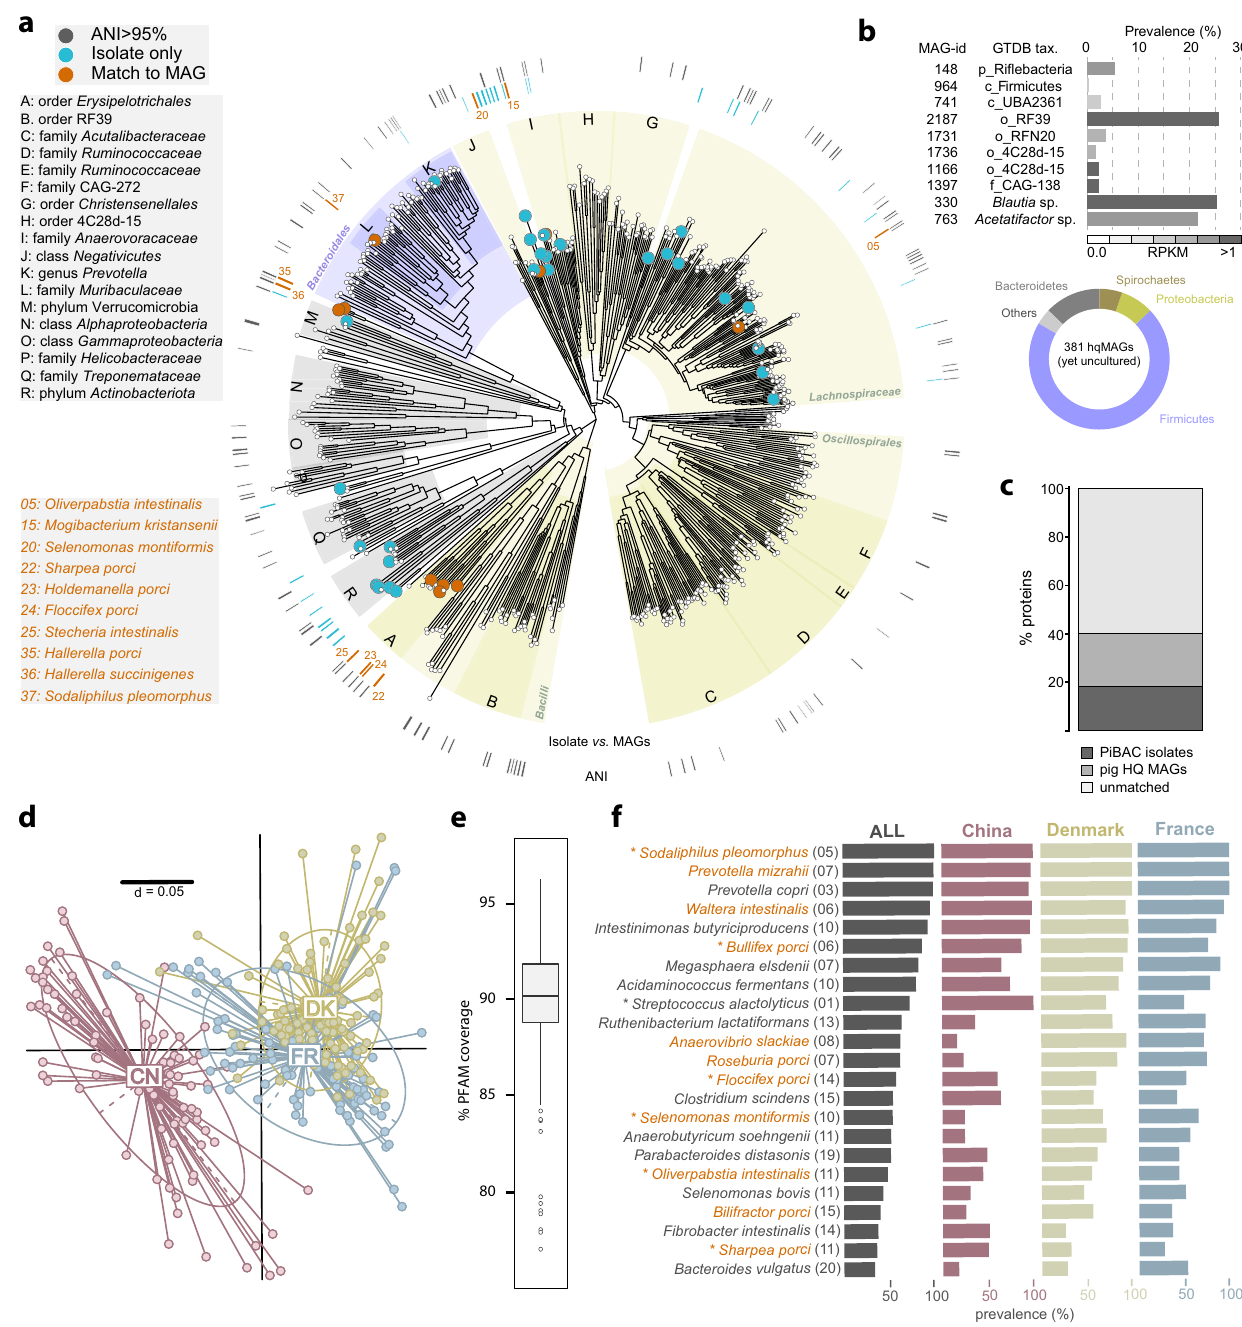
Fig. 5 Metagenome-based diversity and functional prediction. a Phylogenomic tree of high-quality, bacterial metagenome-assembled genomes (MAGs) together with novel taxa within the collection. See text for tree construction and quality thresholds. The grey bars in the outer ring indicate genomes with a species-level match to MAGs archived in GTDB (ANI value >95%) 53 , no matter whether cultured or not. The colours in the inner ring indicate species-level match between the new PiBAC taxa and the MAGs catalogue. b Top: list of most-wanted taxa captured by metagenomics but without a cultured representative. Taxa were selected because they represent high taxonomic ranks and based on high prevalence or abundance. Bottom: coloured ring representing the phylum distribution of all 381 yet uncultured species represented by a high-quality (hq) MAG from the present study. c Contribution of the isolates and hqMAGs collected in the present study to the pig-derived metagenomic gene catalogue (7,685,872 proteins) 18 . d Jaccard similarity plot of PFAM-based metagenomic pro fi les of 284 pig faecal samples according to their country of origin: CN, China; Fr, France; DK, Denmark. e Functional coverage of the metagenomes in d ( n = 284) by all species-level PiBAC genomes. The box plot indicates the median (middle line), 25% and 75% quantiles (bottom and top line, respectively), and 1.5 × inter-quantile range; outliers are indicated with dots. f List of the 23 species most often selected (>50% pigs in at least one country) within minimal communities (20 species on average) best matching the PFAM pro fi les of faecal pig metagenomes. The bar plots show the prevalence of each bacterial species across the entire cohort and in each country. The species marked with a star were identi fi ed as being enriched in pigs based on meta-amplicon or MAGs analysis (Figs. 4c and 5a). The numbers in bracket indicate the median selection rank of individual species across all minimal communities in which they were present. Novel taxa are written in orange